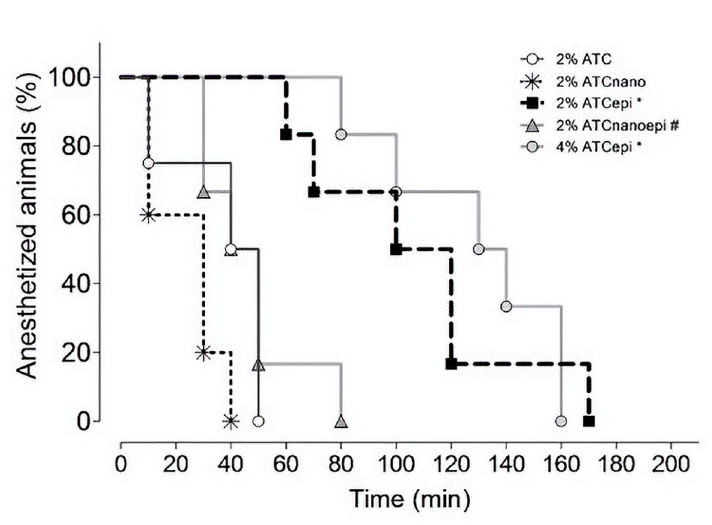
Fig 5. Analgesia success (%) in inflamed tissue after subcutaneous injection. 2% articaine (2% ATC), 2% articaine- loaded poly( ε -caprolactone) nanocapsules (2% ATC nano ), 2% articaine with 1:200,000 epinephrine (2% ATC epi ), 2% articaine-loaded poly( ε -caprolactone) nanocapsules with 1:200,000 epinephrine (2% ATC nanoepi ), and 4% articaine with 1:200,000 epinephrine (4% ATC epi ) (n = 6 rats/group). Log-rank test: � P < 0.01 compared to 2% ATC, 2% ATC nano , and 2% ATC nanoepi ; # P = 0.0344 compared to 2% ATC nano